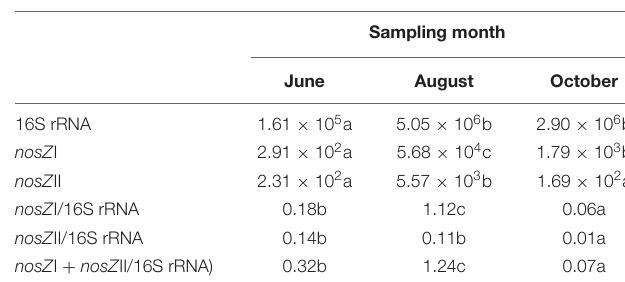
TABLE 3 | Relative abundance of 16S rRNA and clade I and II nosZ genes in sediments from La Caldera lake (Sierra Nevada,